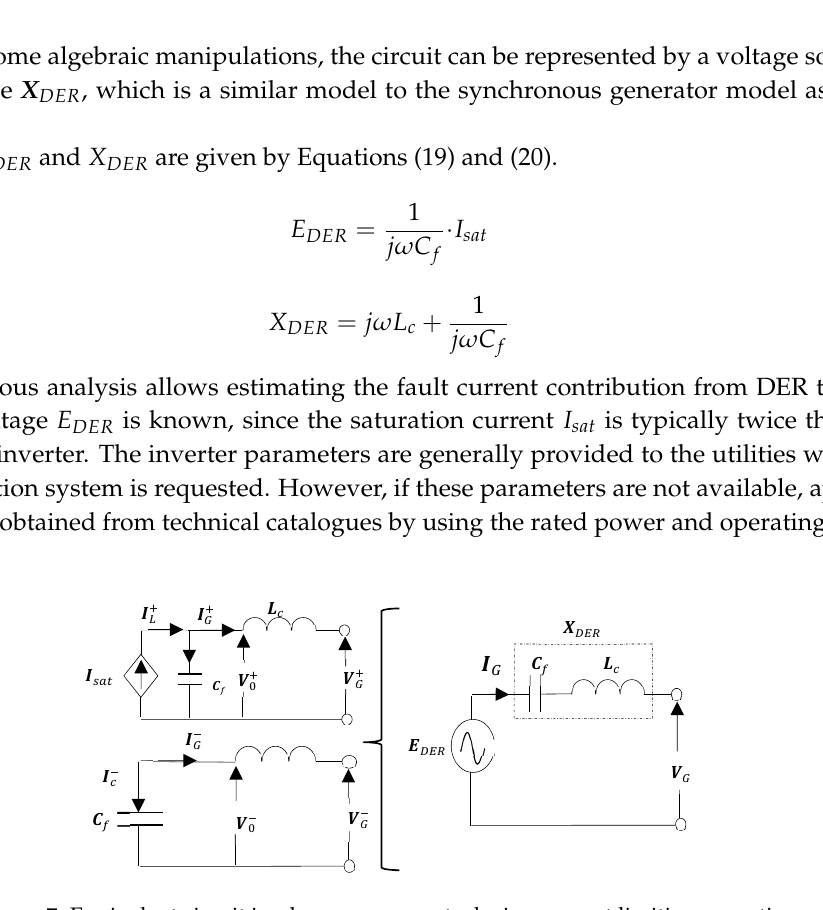
Figure 7. Equivalent circuit in phase components during current limiting operation.